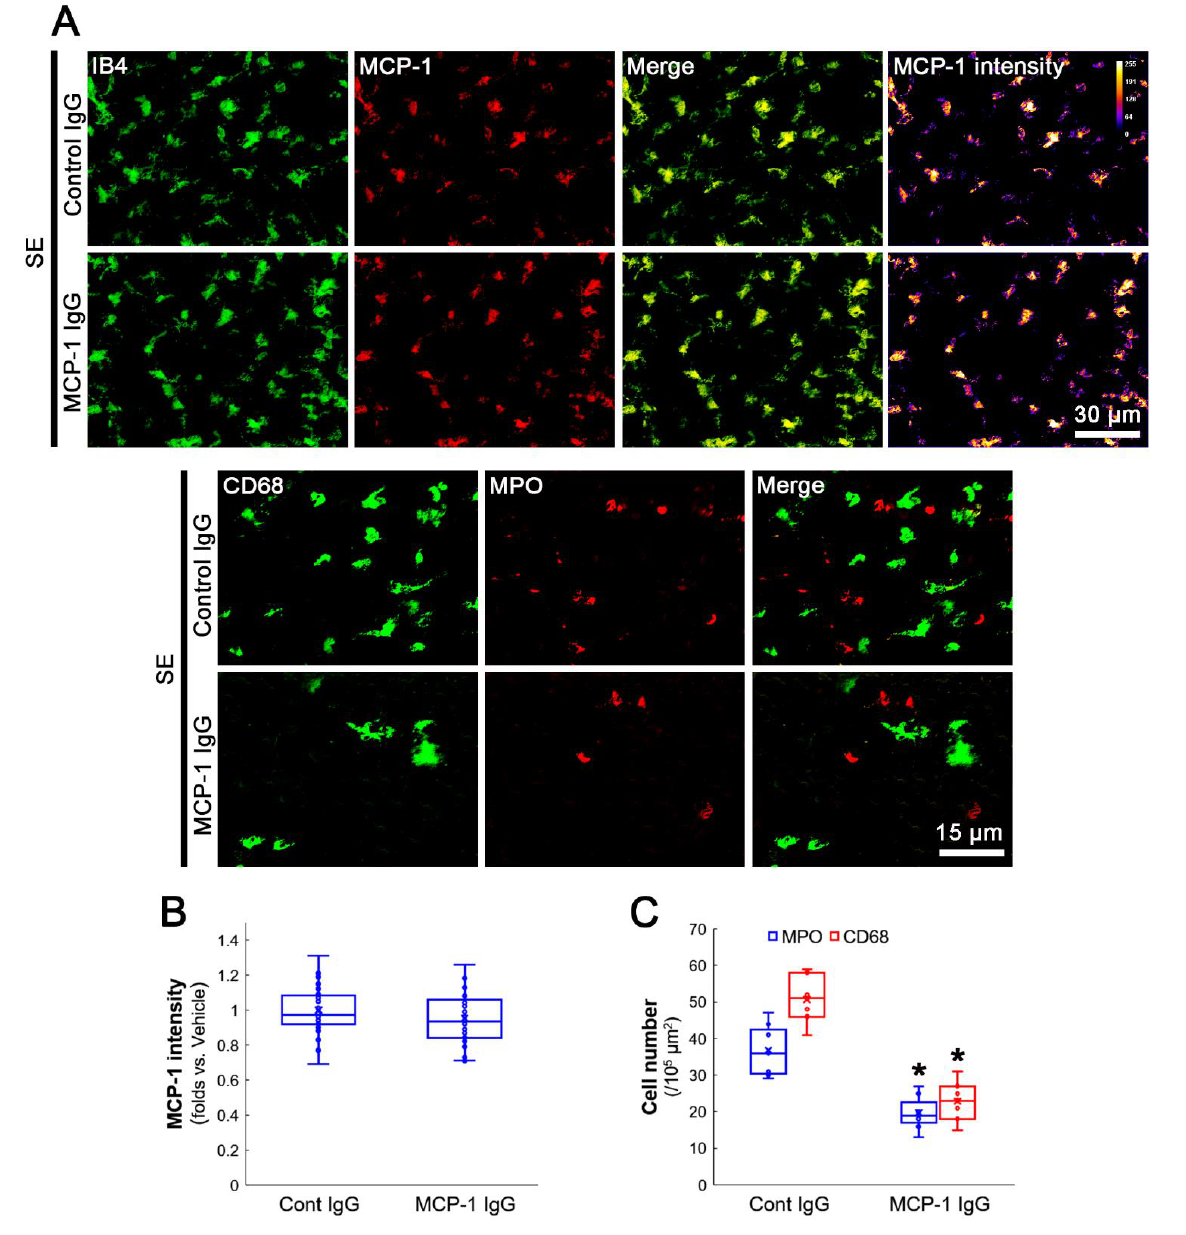
Figure 5. Effects of MCP-1 neutralization on MCP-1 induction and leukocyte infiltration in the FPC following SE. As compared to control IgG, MCP-1 neutralization attenuates leukocyte infiltration induced by SE. ( A ) Representative photos of MCP-1 expression and leukocyte infiltration in the FPC following SE. ( B ) Quantification of the MCP-1 intensity in microglia ( n = 40 cells in 7 rats, respectively). ( C ) Quantification of the number of infiltrating leukocytes. * p < 0.05 vs. control IgG ( n = 7 rats,